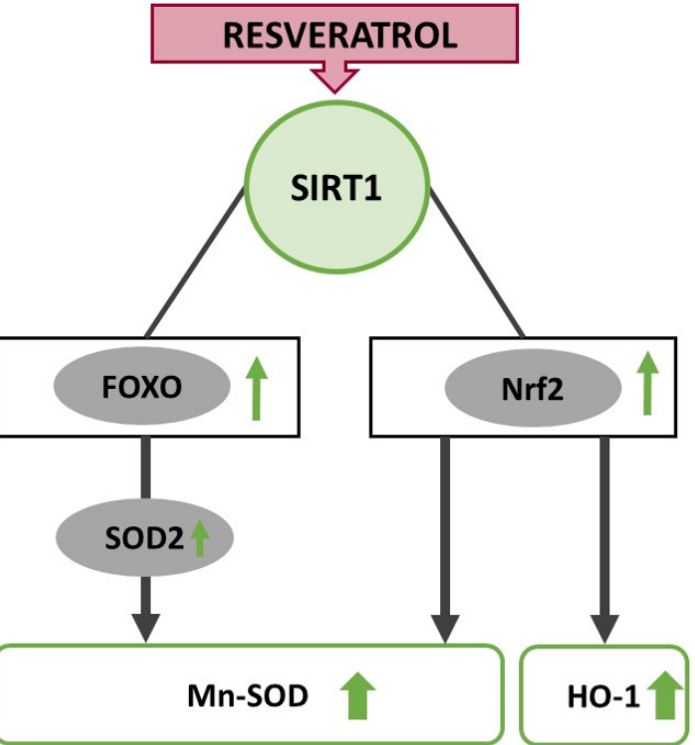
Figure 3. Resveratrol-induced signal transduction leading to reduced oxidative stress levels through upregulation of FOXO (FOXO1, FOXO3a and FOXO4) and